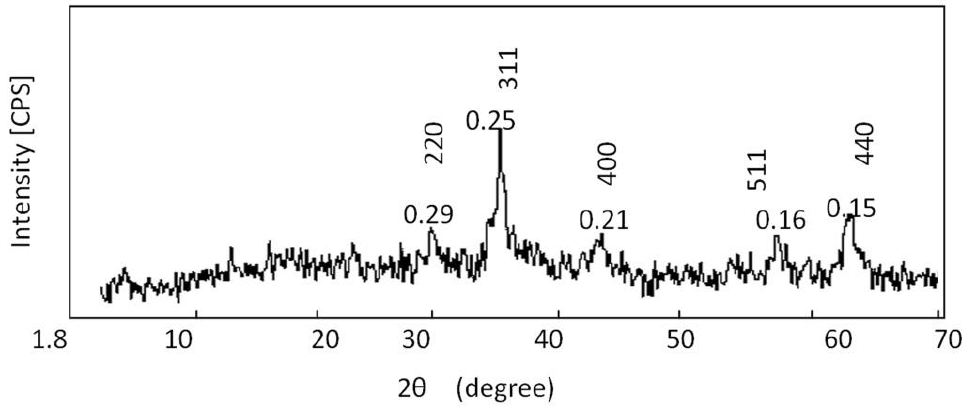
Figure 7. X-ray diffraction pattern of the CoFe 2 O 4 -supported Co-Fe LDH after thermal treatment.